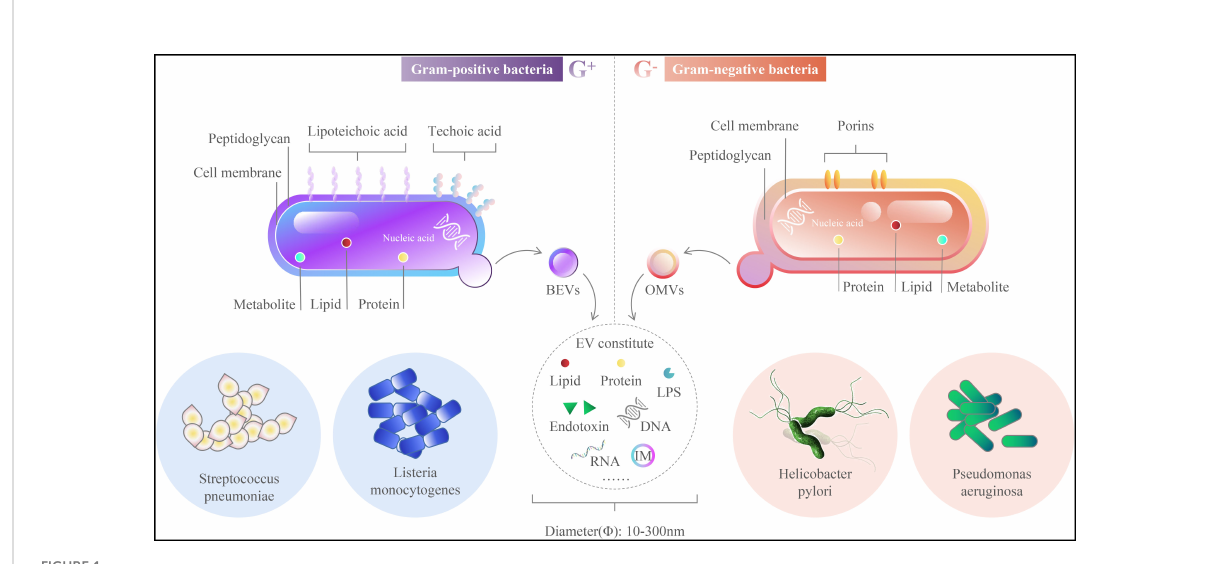
FIGURE 1 Outer Membrane Vesicles main